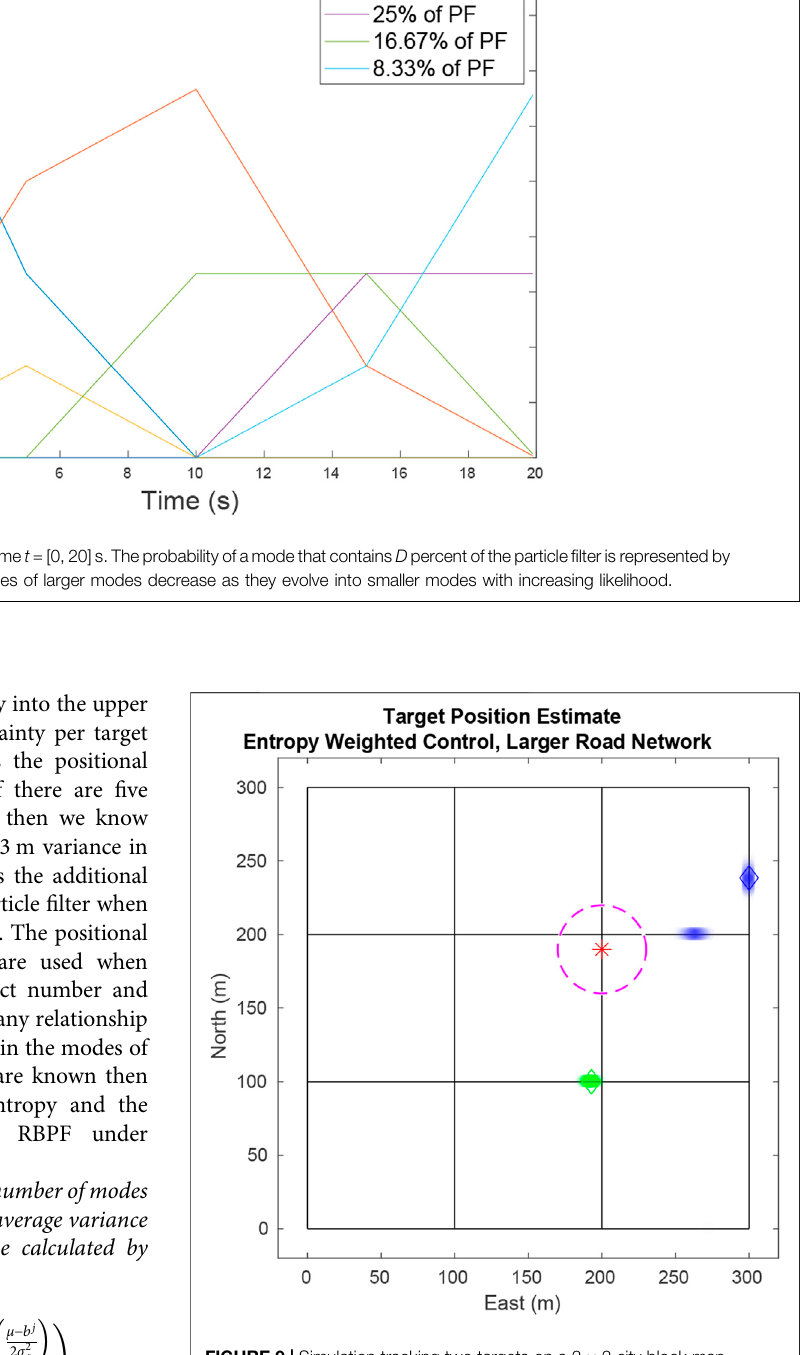
FIGURE 9 | Simulation tracking two targets on a 3 × 3 city block map. Here the UAV is drawn toward the blue target because its estimate has higher entropy as seen by the two particle modes (blue